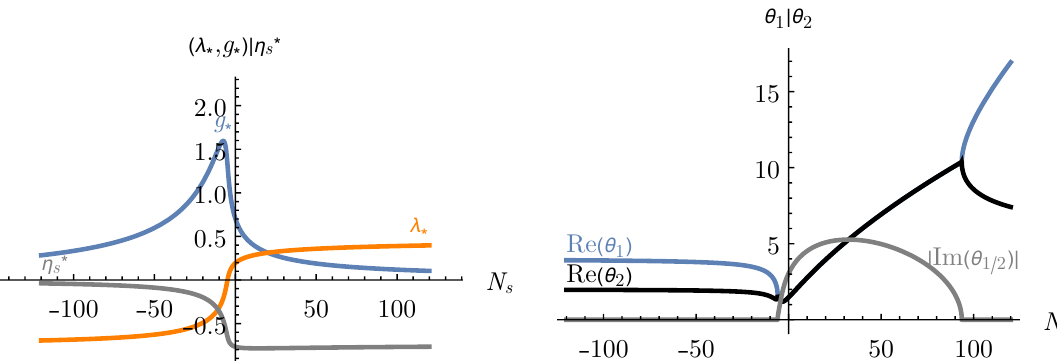
Figure 3 . Characteristics of the NGFP in the minimally coupled gravity-scalar system as a function of N s . Its position in the (cid:21) - g -plane and the resulting scalar anomalous dimension (cid:17) (cid:3) the left panel while the stability coe(cid:14)cients are displayed in the right